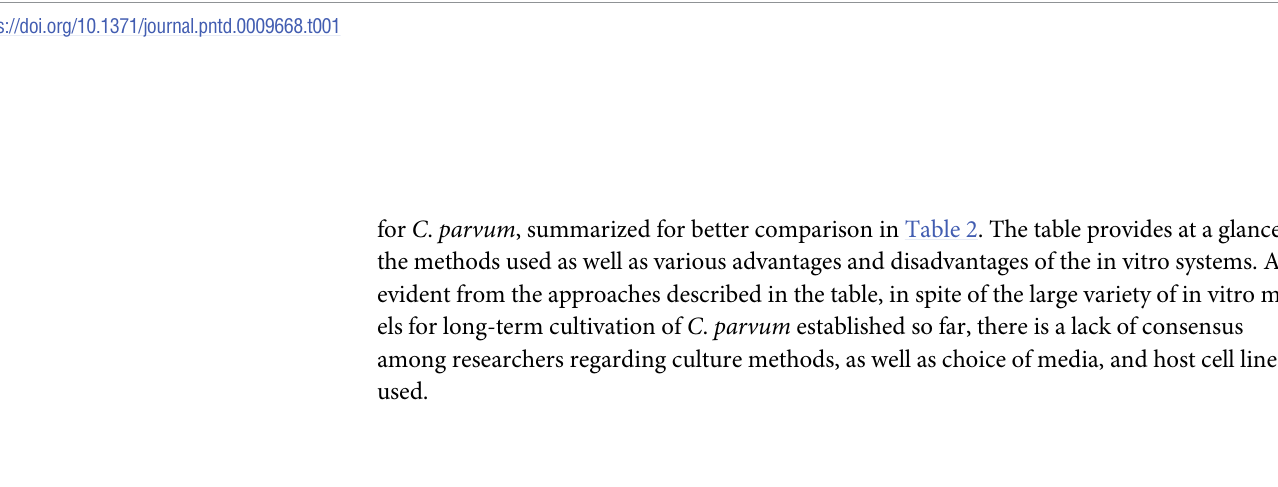
for C . parvum , summarized for better comparison in Table 2. The table provides at a glance the methods used as well as various advantages and disadvantages of the in vitro systems. As evident from the approaches described in the table, in spite of the large variety of in vitro mod- els for long-term cultivation of C . parvum established so far, there is a lack of consensus among researchers regarding culture methods, as well as choice of media, and host cell lines used.